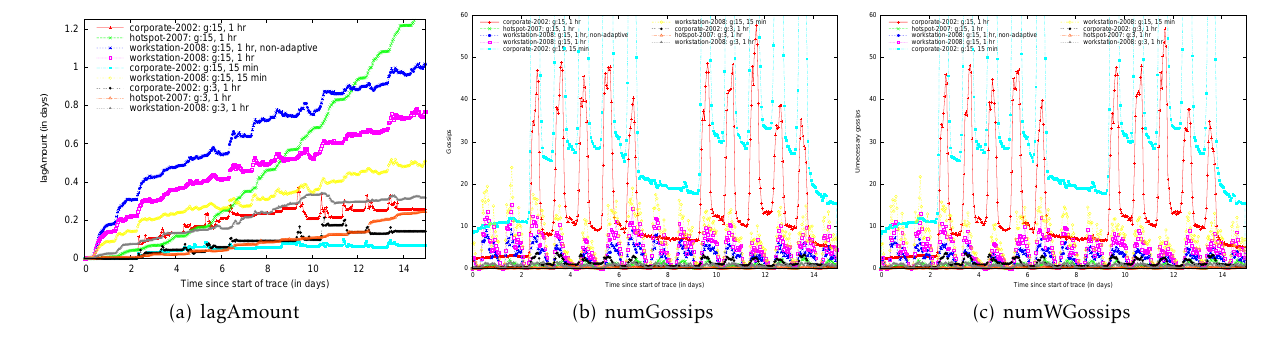
Figure 14. P2P-push (adaptive duration by default)